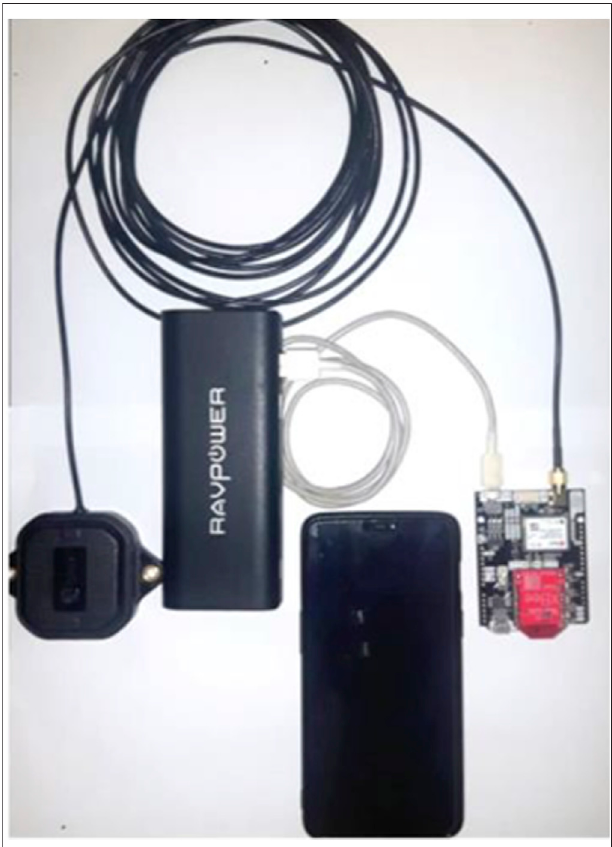
FIGURE 1 | Device set-up: simpleRTK2B, antenna, power bank, and